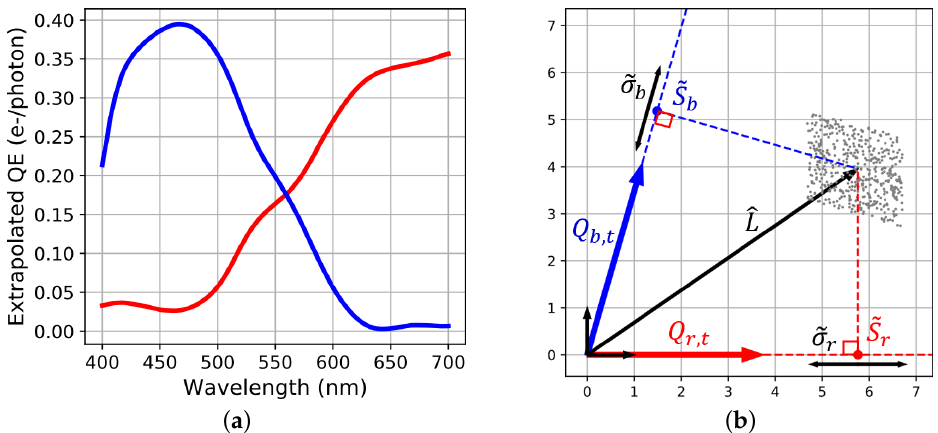
Figure 8. Linear regression over the X-Rite ColorChecker Classic ( a ) Extrapolated sensitivities F t obtained by calculating the pseudo-inverse of the reconstruction matrix. ( b ) Associated vector basis and spectral reconstruction in the sensor space. The orthogonal projections of signals and standard deviation (cid:101) S and (cid:101) σ are found with Equation (8) but using (cid:107) Q r , t (cid:107) (cid:107) Q (cid:107) b 2